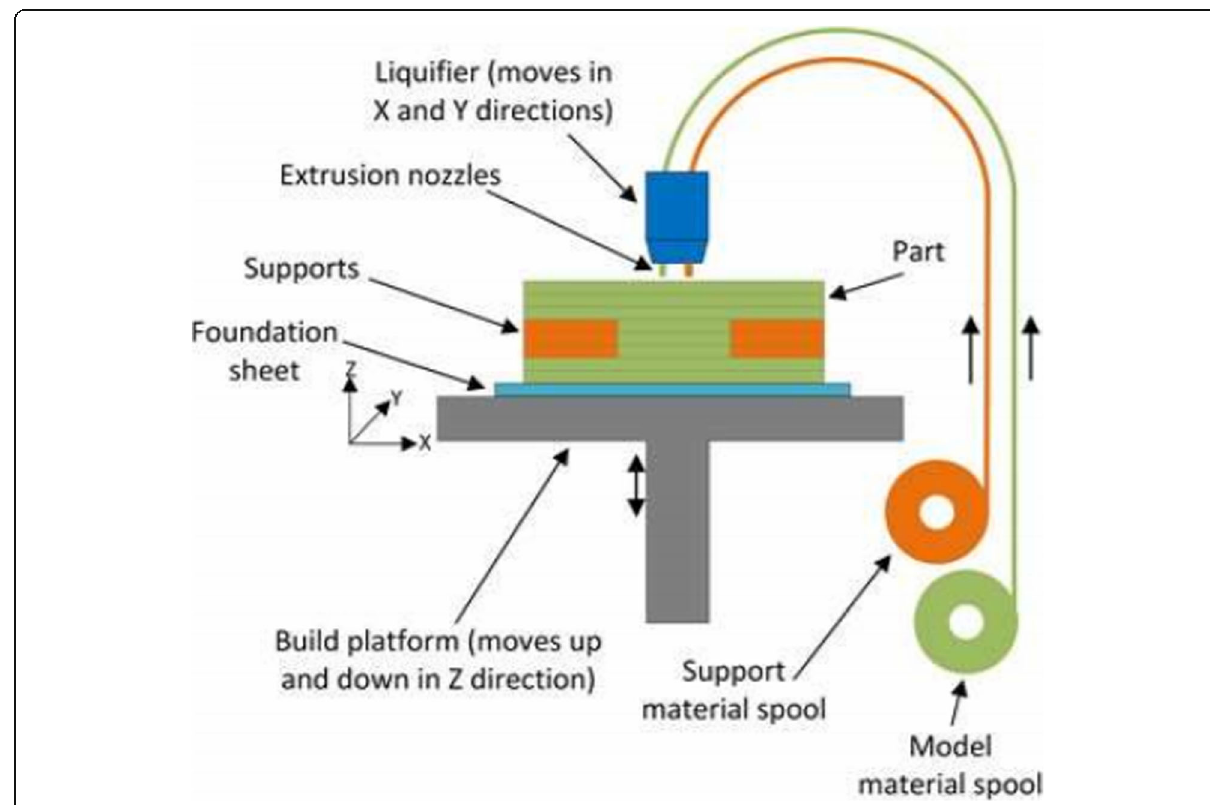
Fig. 1 Schematic diagram showing the important components of a FDM printer